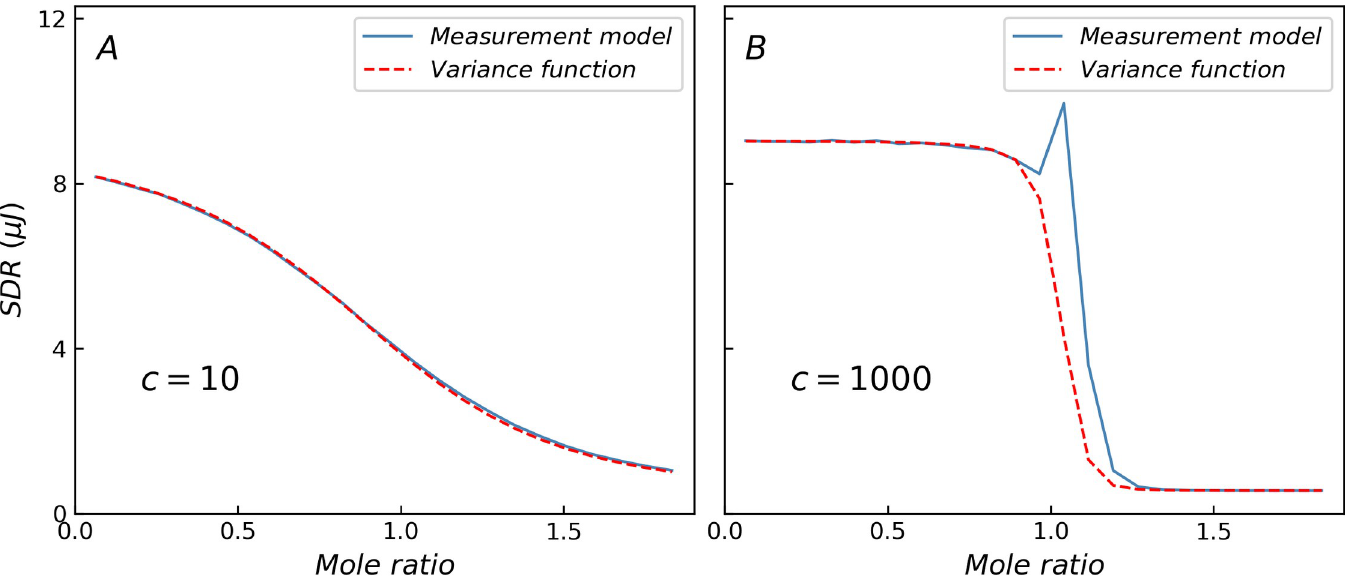
Fig 1. Comparison of SDR predicted by ITC measurement model and variance function. (A) When c = 10, the results of two methods are the same. (B) When c = 1000, the variance function cannot describe the specific changes in the transition region.